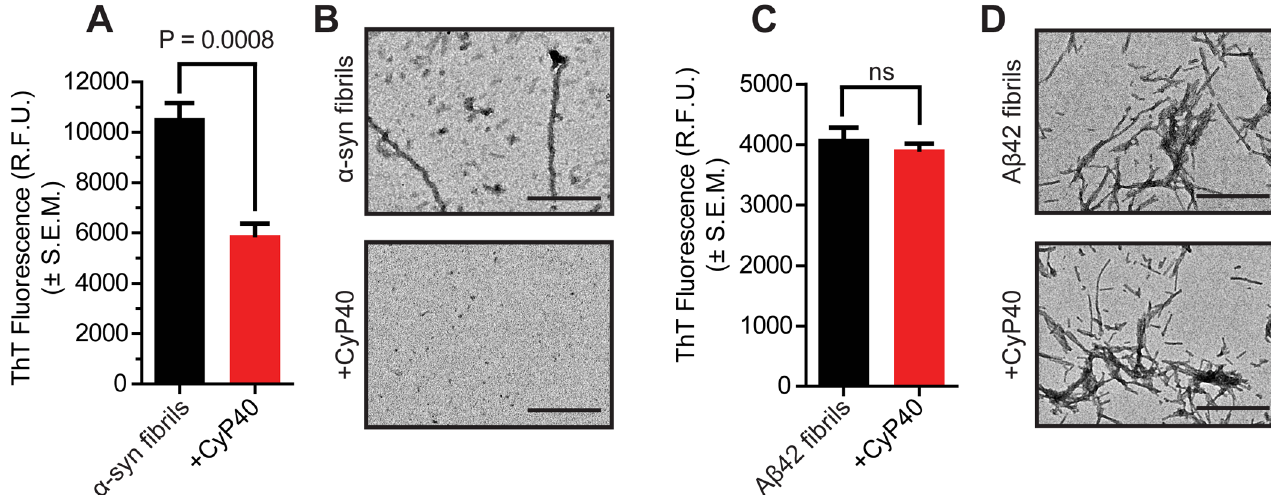
Fig 5. Cyclophilin 40 (CyP40) disaggregated α -synuclein, but not amyloid 1-42 peptide (A β 42)fibrils. (A) ThioflavinT (ThT) fluorescence of A53T α -synuclein( α -syn) fibrils ± CyP40 protein (unpaired t test, n = 4). (B) Representative transmission electron microscopy (TEM) images of α -syn A53T fibrils ± CyP40 (60,000 × magnification; scale bar 400 nm) (C) ThT fluorescence of A β 42 fibrils ± CyP40 protein (unpaired t test, n = 4). (D) Representative TEM images of A β 42 fibrils ± CyP40 (60,000 × magnification; scale bar 400 nm). The numerical data used in panels 5A and 5C can be found in S1 Data. RFU, relativefluorescence unit; SEM, standard error of the mean.